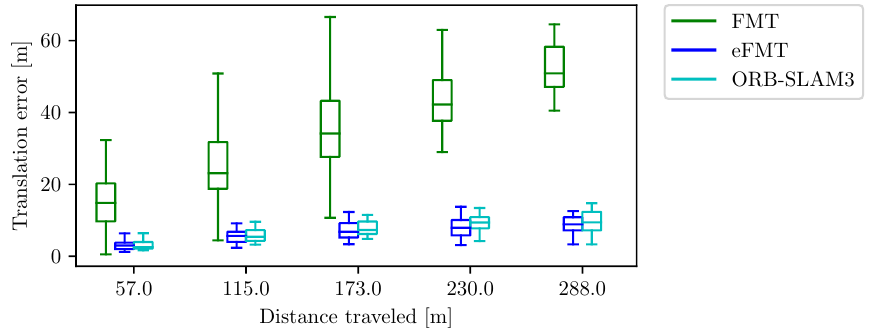
Figure 14. Absolute translation error on the UAV dataset. SVO and DSO fail to track the images.